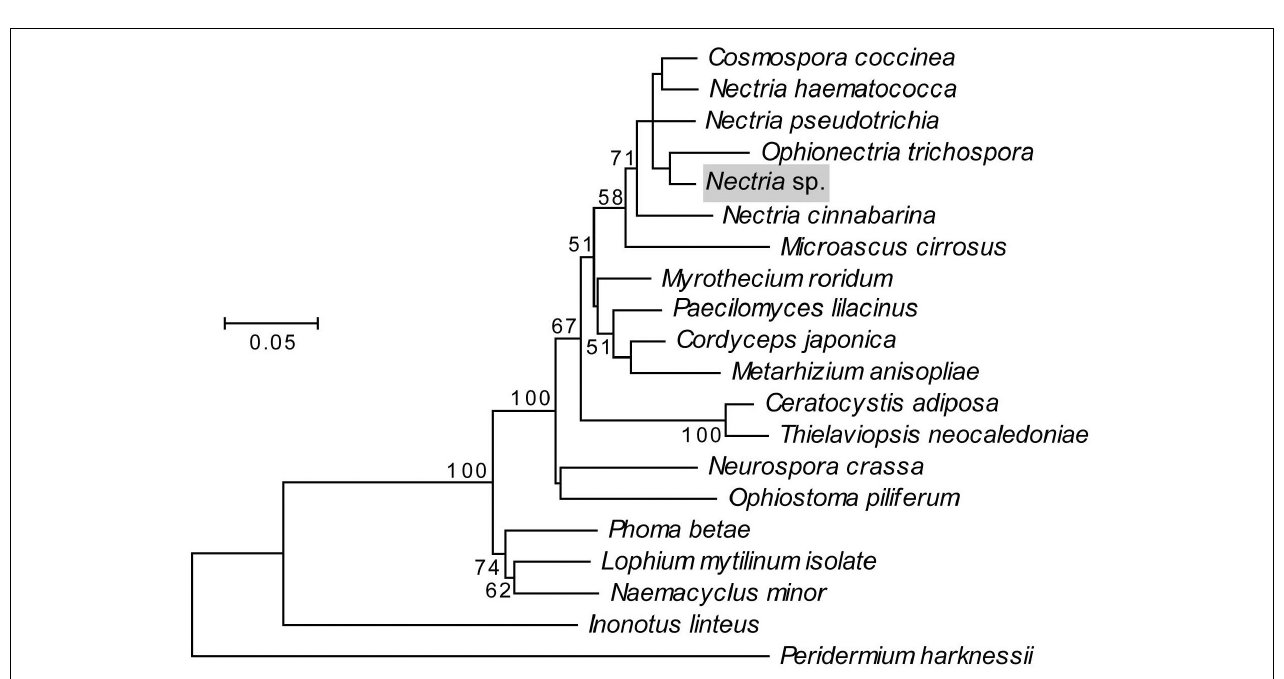
0.02 mM. R. sulphurea grew in all test conditions